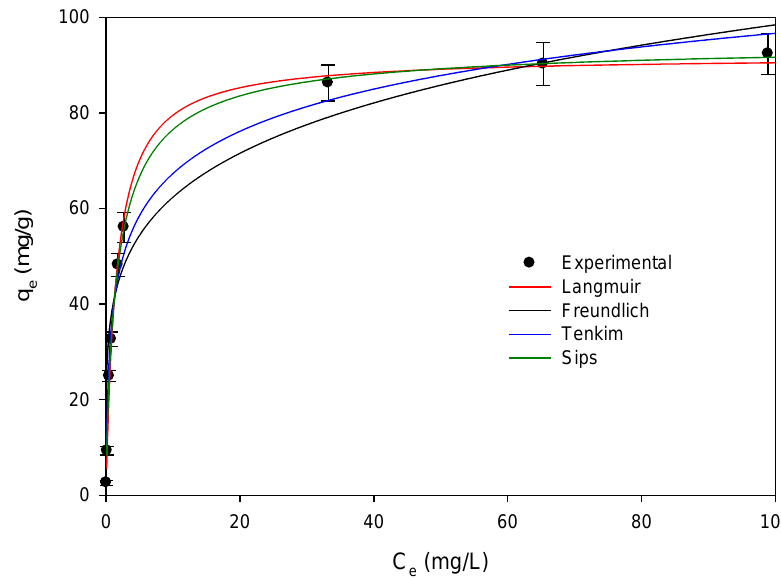
Figure 6. Equilibrium adsorption of BPA with activated carbon. Experimental results and adjustment to the selected models.